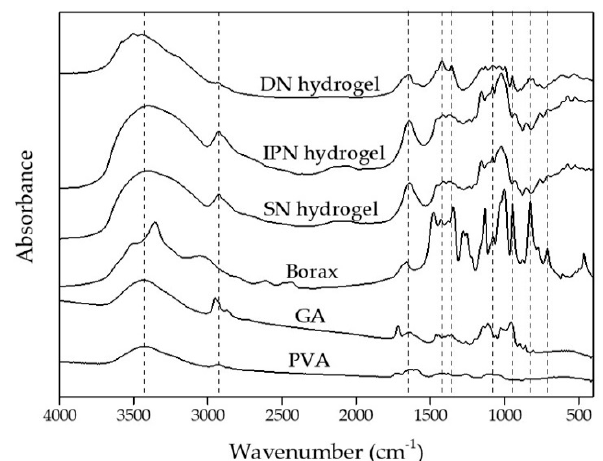
Figure 1. FTIR spectra of PVA, GA, Borax, and SN, IPN, and DN starch